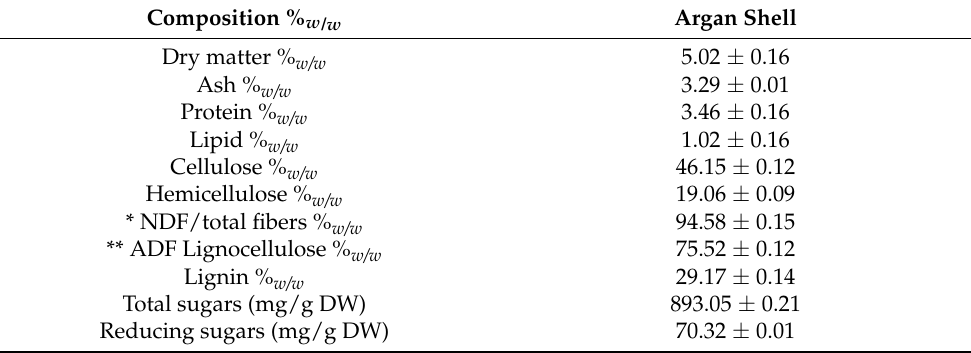
Table 1. Chemical composition of argan